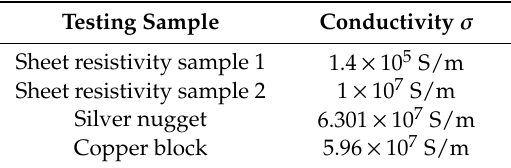
Table 2. Sample conductivity test